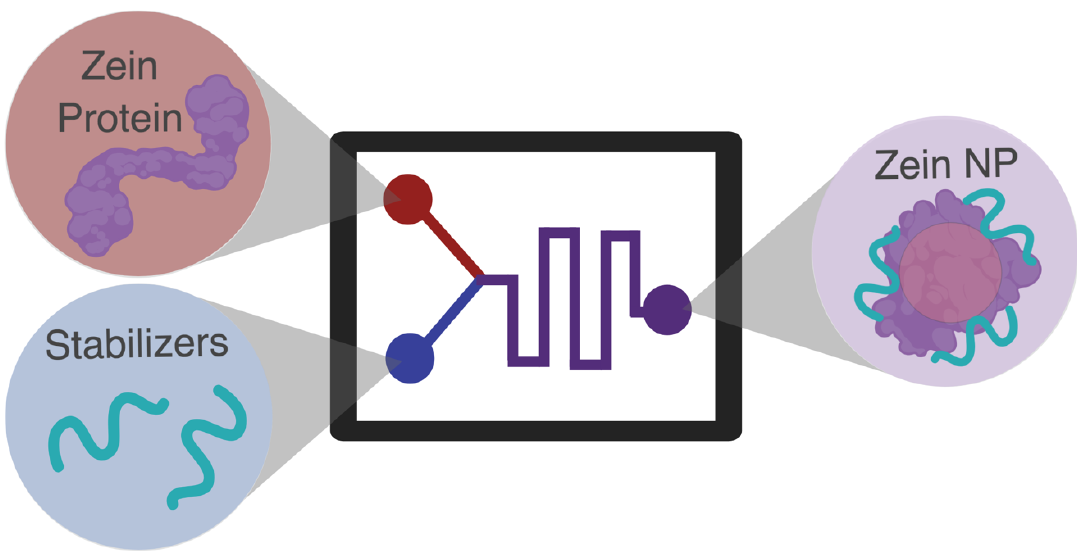
Figure 1. A graphical depiction of the Zein nanoparticle (NP) synthesis using a coprecipitation microfluidics system. At the inlet channels, the organic phase is indicated in red while the aqueous phase is blue.